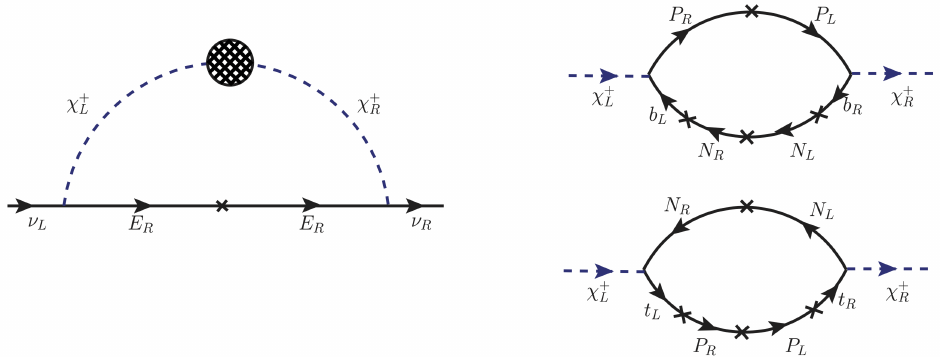
Figure 3. The longitudinal W ± gauge boson contributions to the neutrino mass, expressed in L,R terms of the Goldstone boson